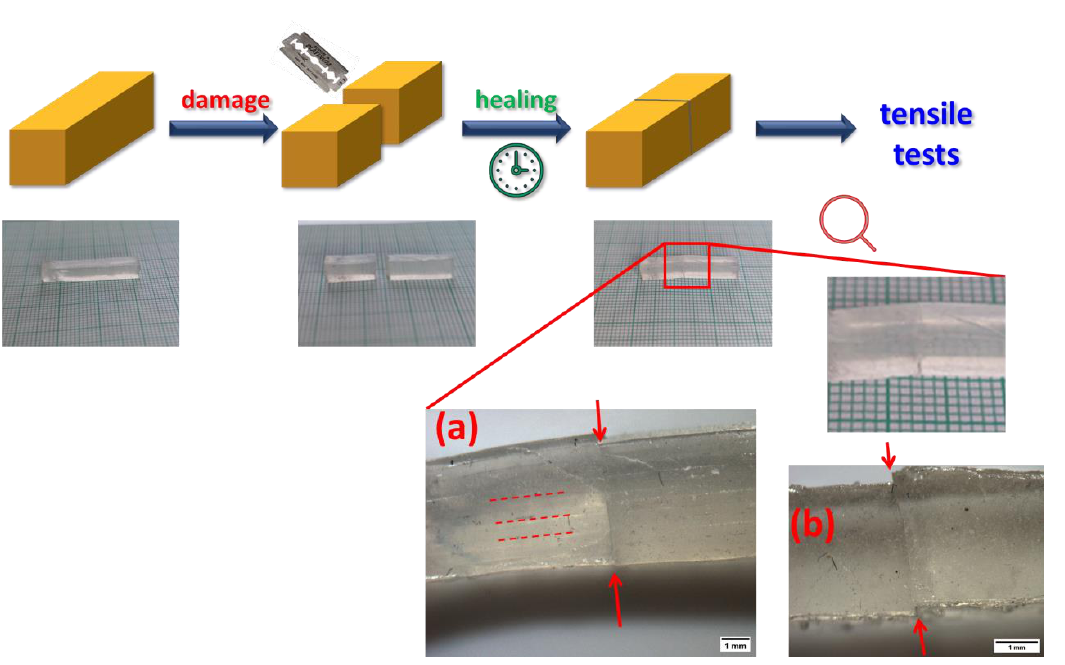
Figure 9. Cutting and re-connecting the samples for self-healing tests; ( a , b ): detail of the place of healing of a previously cut 4R-10S sample, where the red arrows highlight the line of the previous cutting: ( a ): view with visible laminated layers (highlighted by dotted lines) in the thick sample (lamination also occurred via self-healing); ( b ): view perpendicularly to the laminated layer.